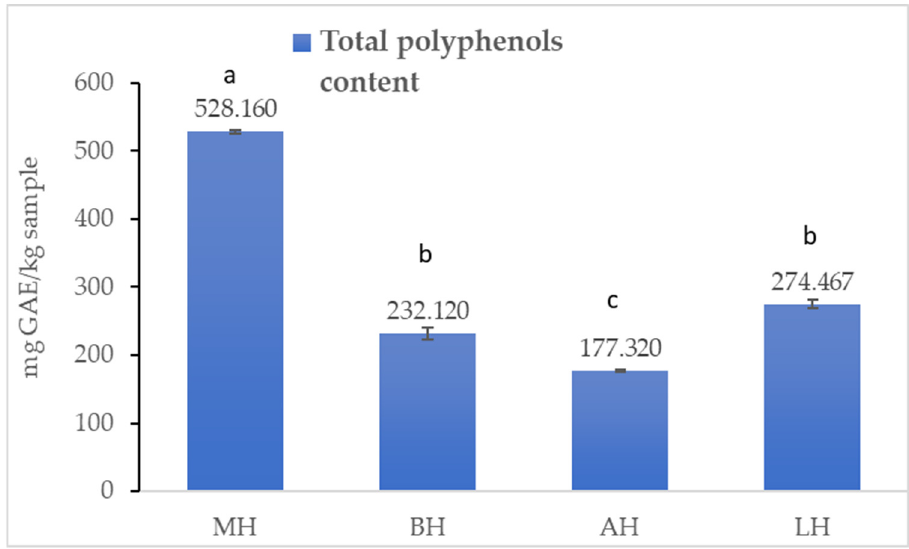
Figure 1. Total polyphenolic content of the honey samples. Mean values are expressed as mg gallic acid equivalent GAE/kg sample. The error bars indicate the standard deviation. Different letters among samples indicate significant differences ( p < 0.05) among values according to the t -test.